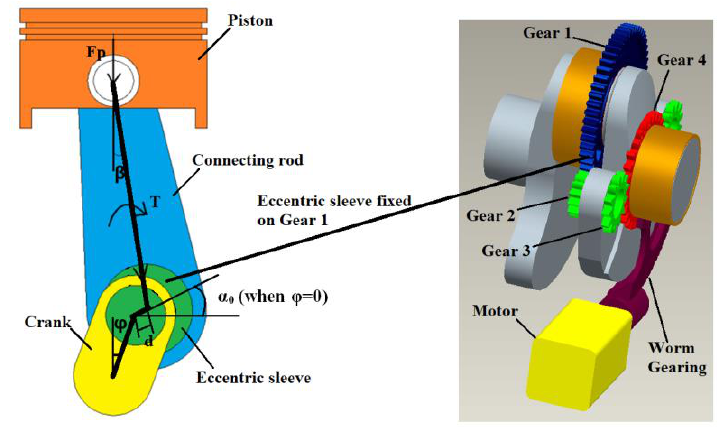
Figure 1. Force analysis and gears position of the dual shaft control variable compression ratio (DSC-VCR). In Equation (1), α 0 is the initial eccentric phase, which is the angle between the eccentric sleeve and the horizontal direction at compression top dead center (TDC) (φ=0°). Fp is the net force of piston, which is the summary of the gas force, and inertia force. β is the angle between the connecting rod and the vertical direction. d is the eccentric size.